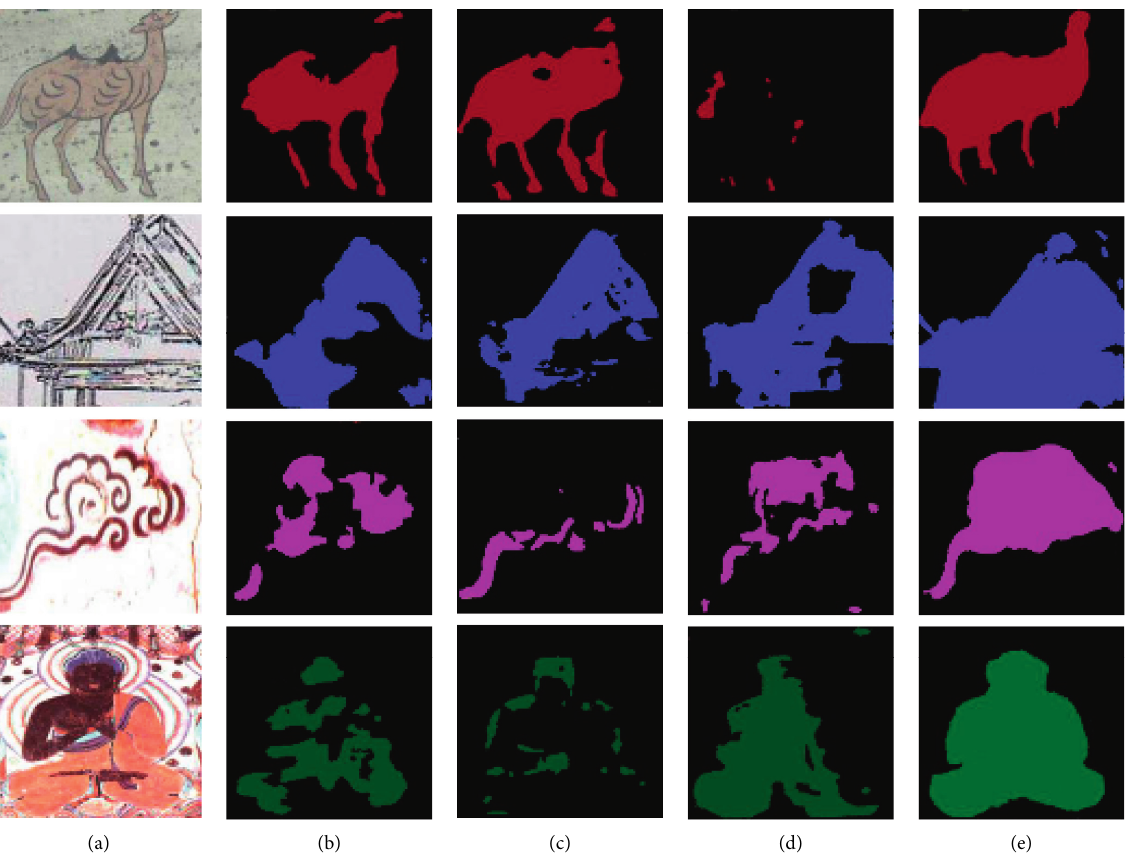
Figure 6: Comparison of segmentation effects. (a) Sample image. (b) Model 1. (c) Model 2. (d) Model 3. (e) MC-DM.